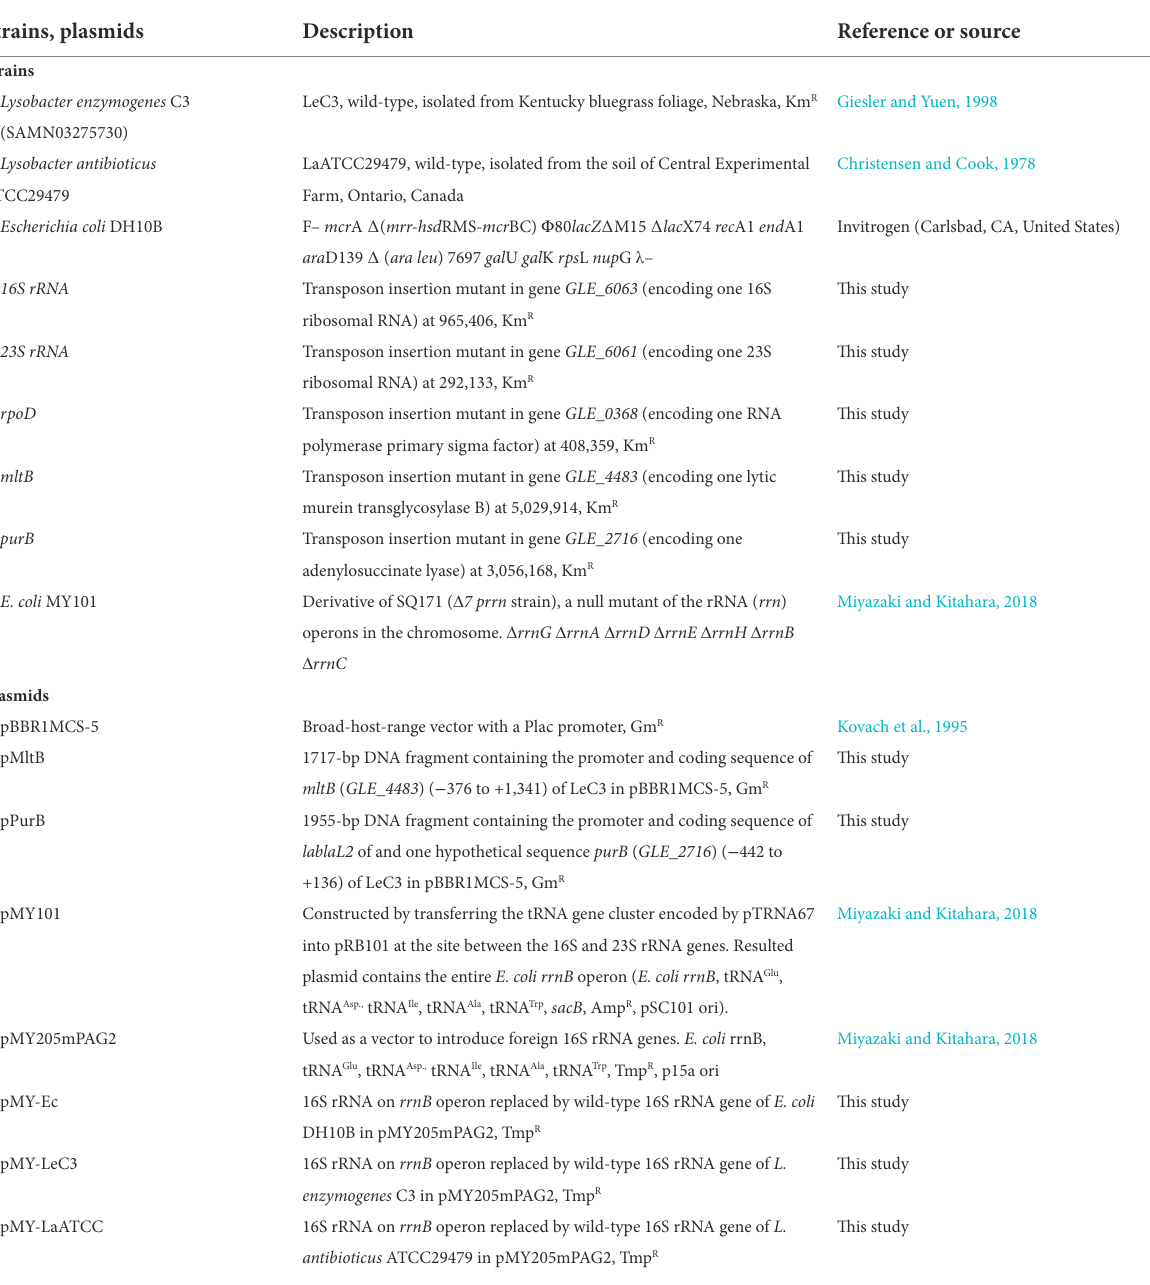
TABLE 1 Bacterial strains and plasmids used in this study. Strains, plasmids